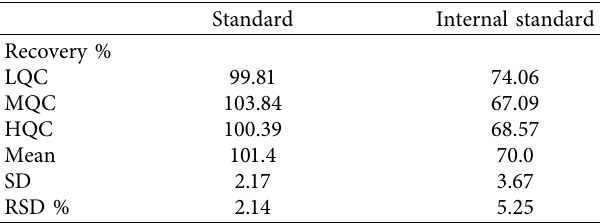
Table 4: Recovery for vardenafil (standard) and internal standard.